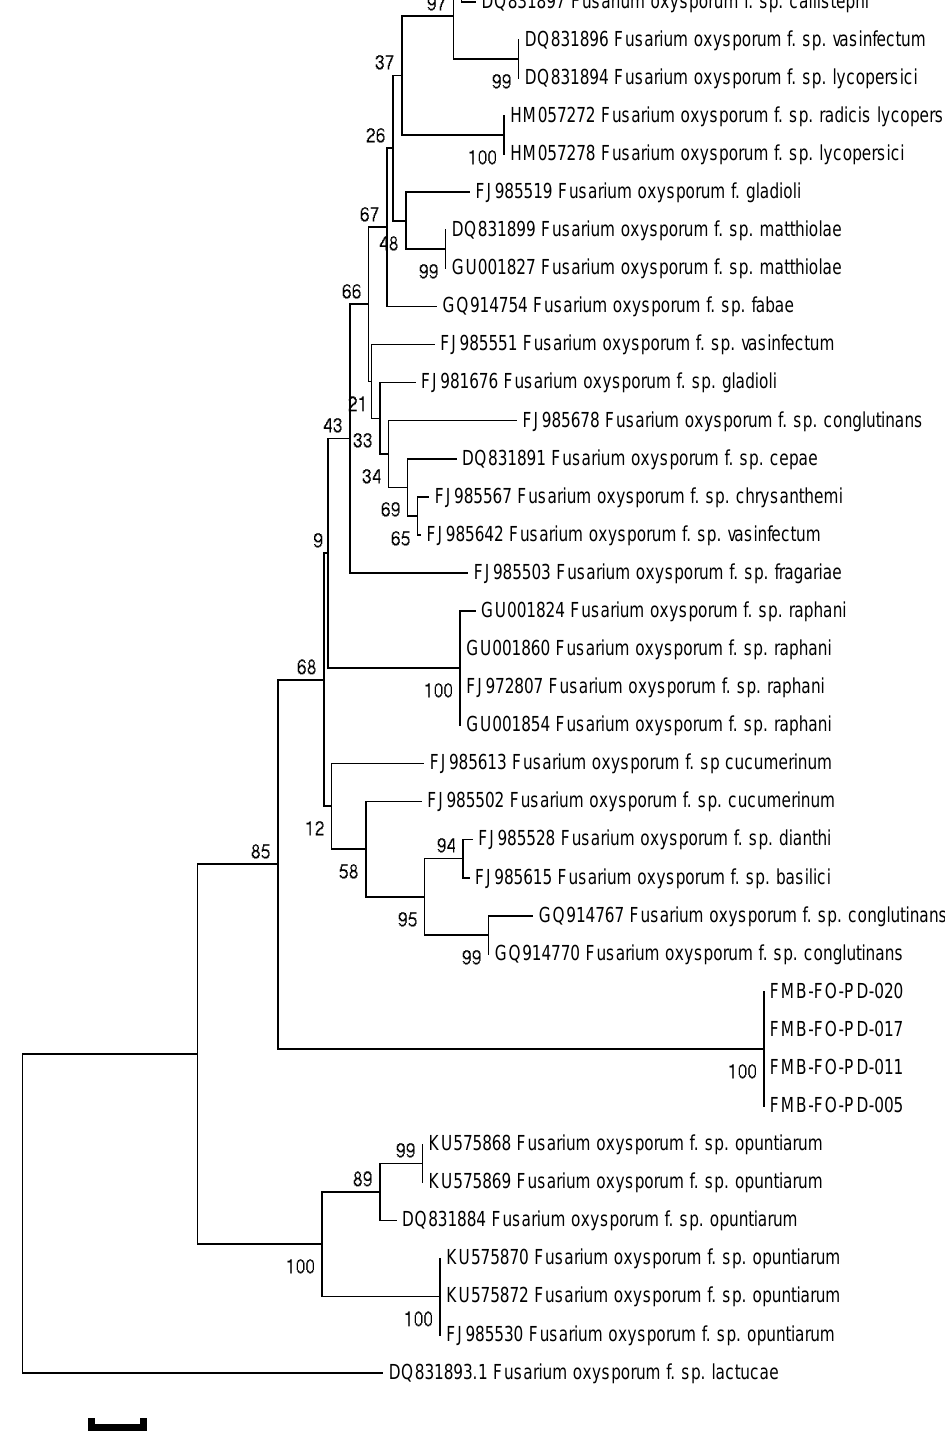
Figure 3. Phylogenetic tree based on the intergenic spacer (IGS) region of rDNA, using MEGA6.06 software under Neighbor-Joining (NJ) analysis, displayed a distinct and separate clade of the F. oxysporum isolates from other forma specialis with 100% bootstrap support.